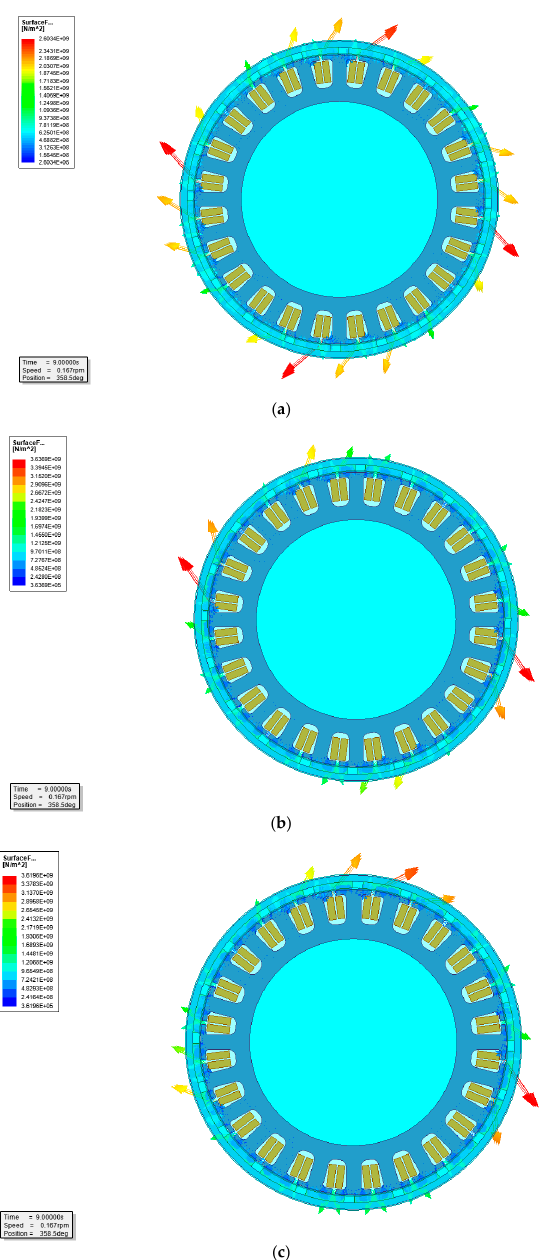
Figure 5. Surface force density: QCO ( a ); DCO A and C ( b ); DCO A and B ( c )—variant I.